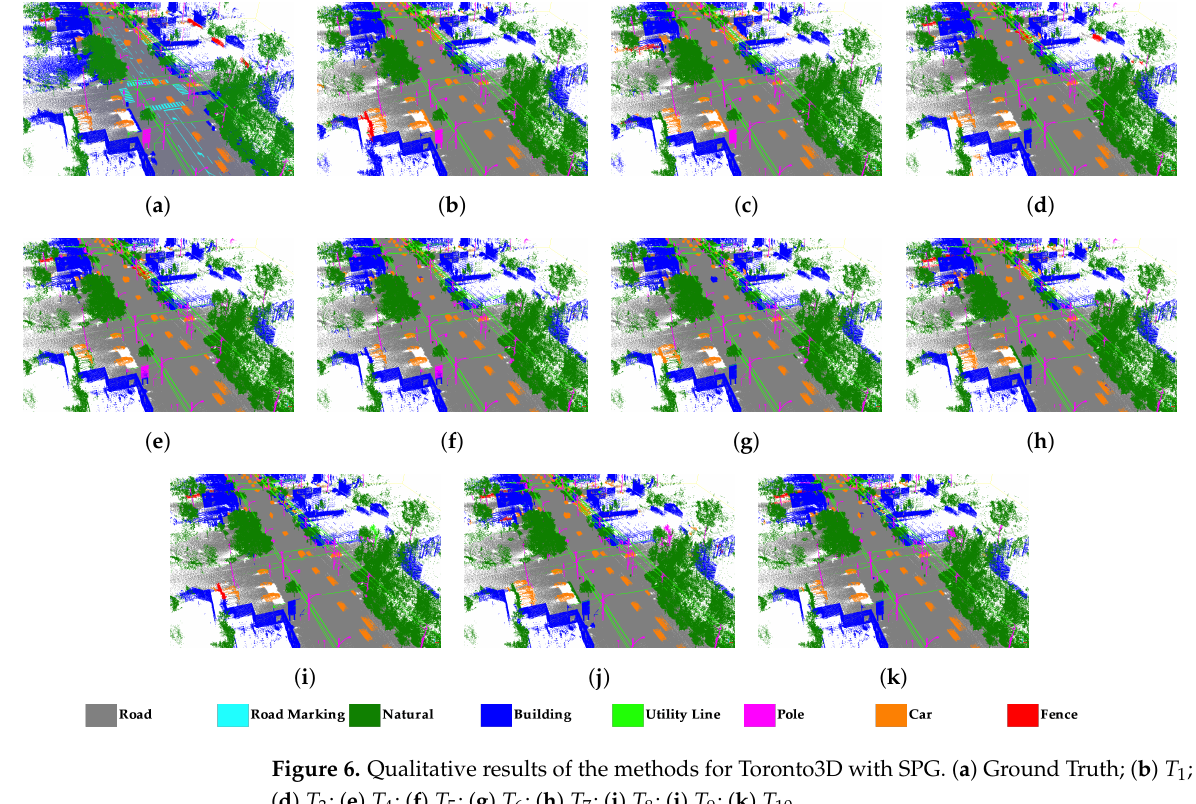
Figure 6. Qualitative results of the methods for Toronto3D with SPG. ( a ) Ground Truth; ( b ) T 1 ; ( c ) T 2 ;